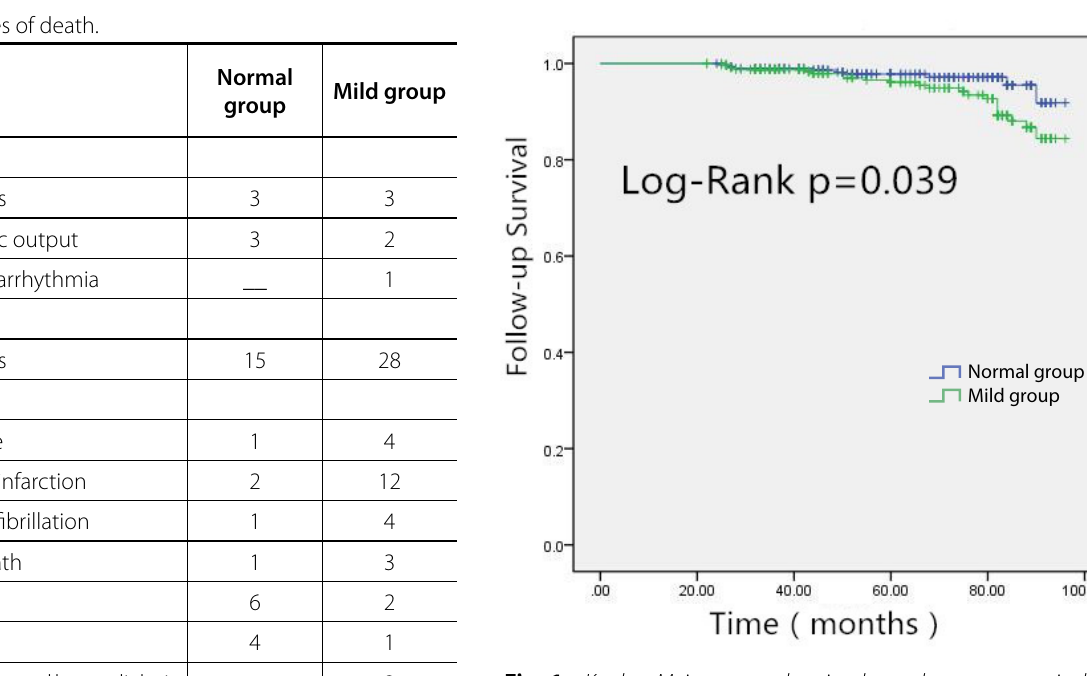
Fig. 1 - Kaplan-Meier curves showing better long-term survival in patients with normal pre-operative renal function in comparison to mild preoperative renal insufficiency (χ2=4.255, P=0.039).